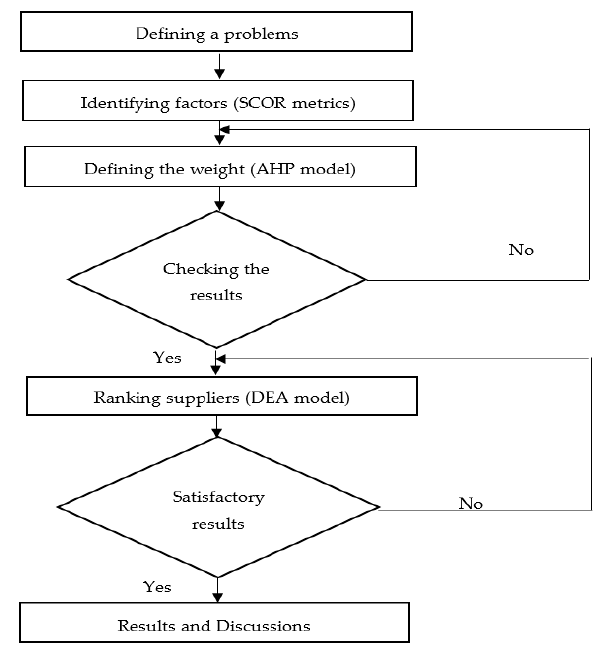
Figure 1. Research graph. SCOR: Supply Chain Operation Reference; AHP: analytic hierarchy process; DEA: Data Envelopment Analysis.